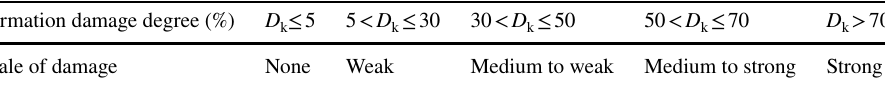
Table 1 Evaluation criteria for degree of alkalinity sensitivity damage